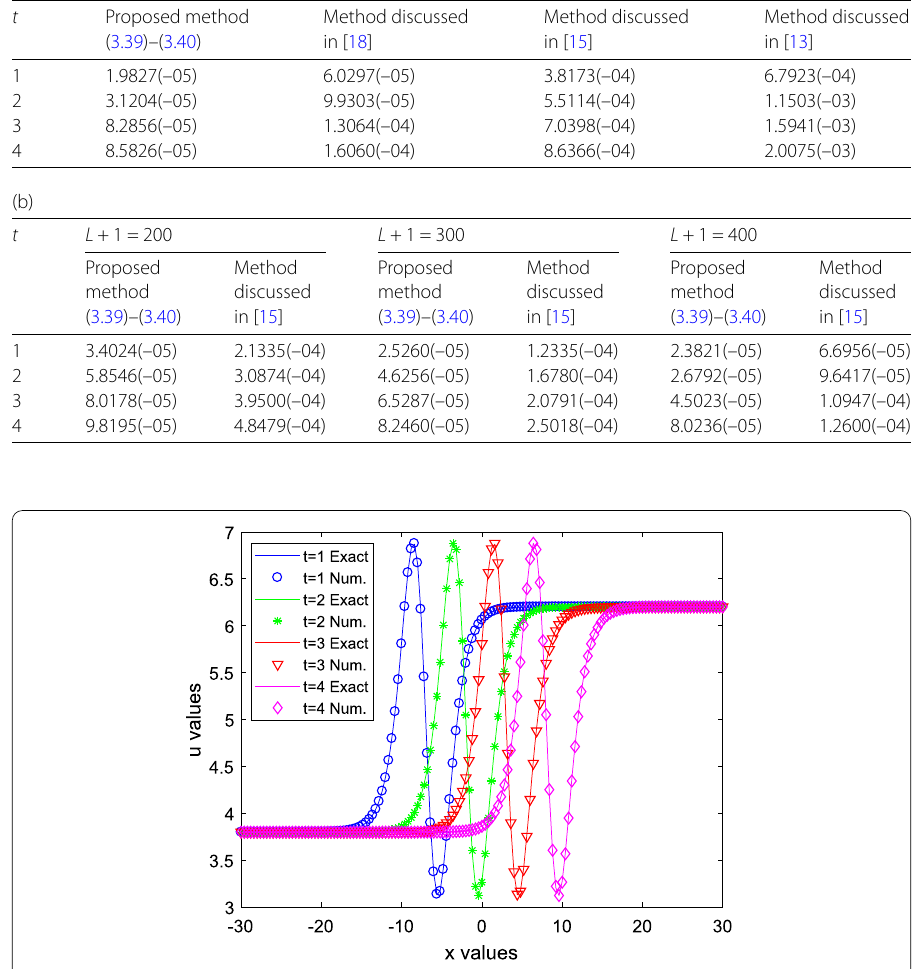
Figure 1 Example 1: Comparison between numerical and exact solutions at different time